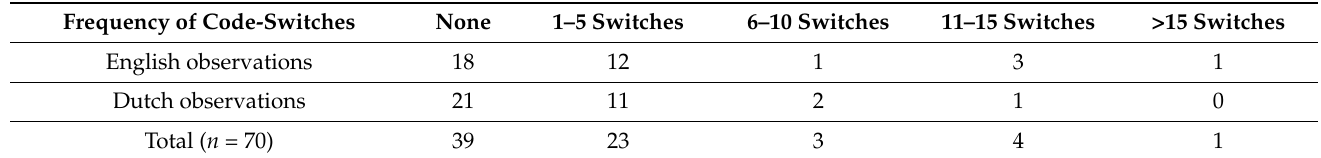
Table 3. Number of code-switches in the Dutch and English